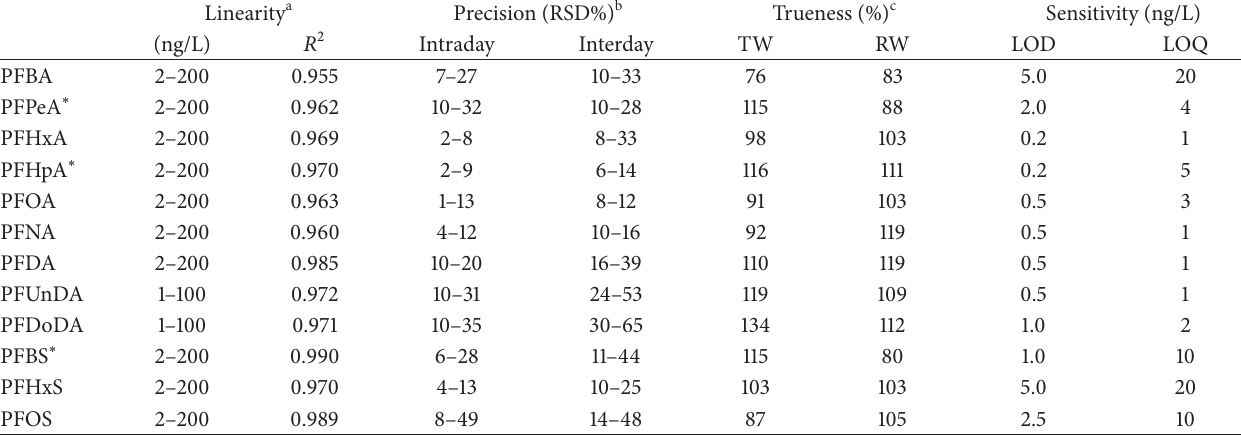
Table 3: Validation parameters (injection in “early gradient” mode of 5mL of acidified standards and